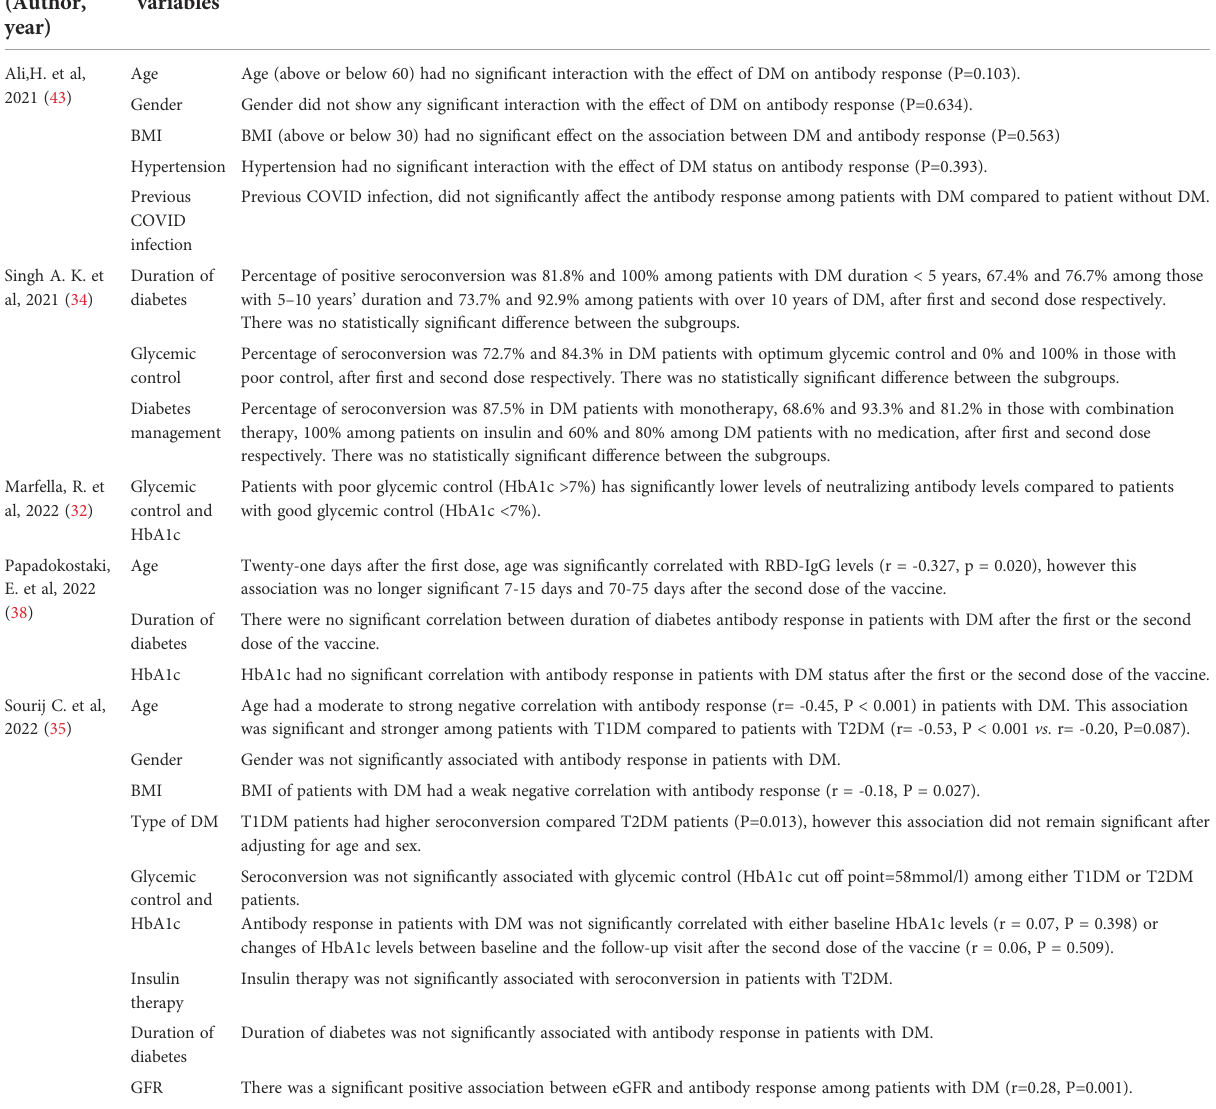
TABLE 4 Outcomes of the included studies based on diabetic